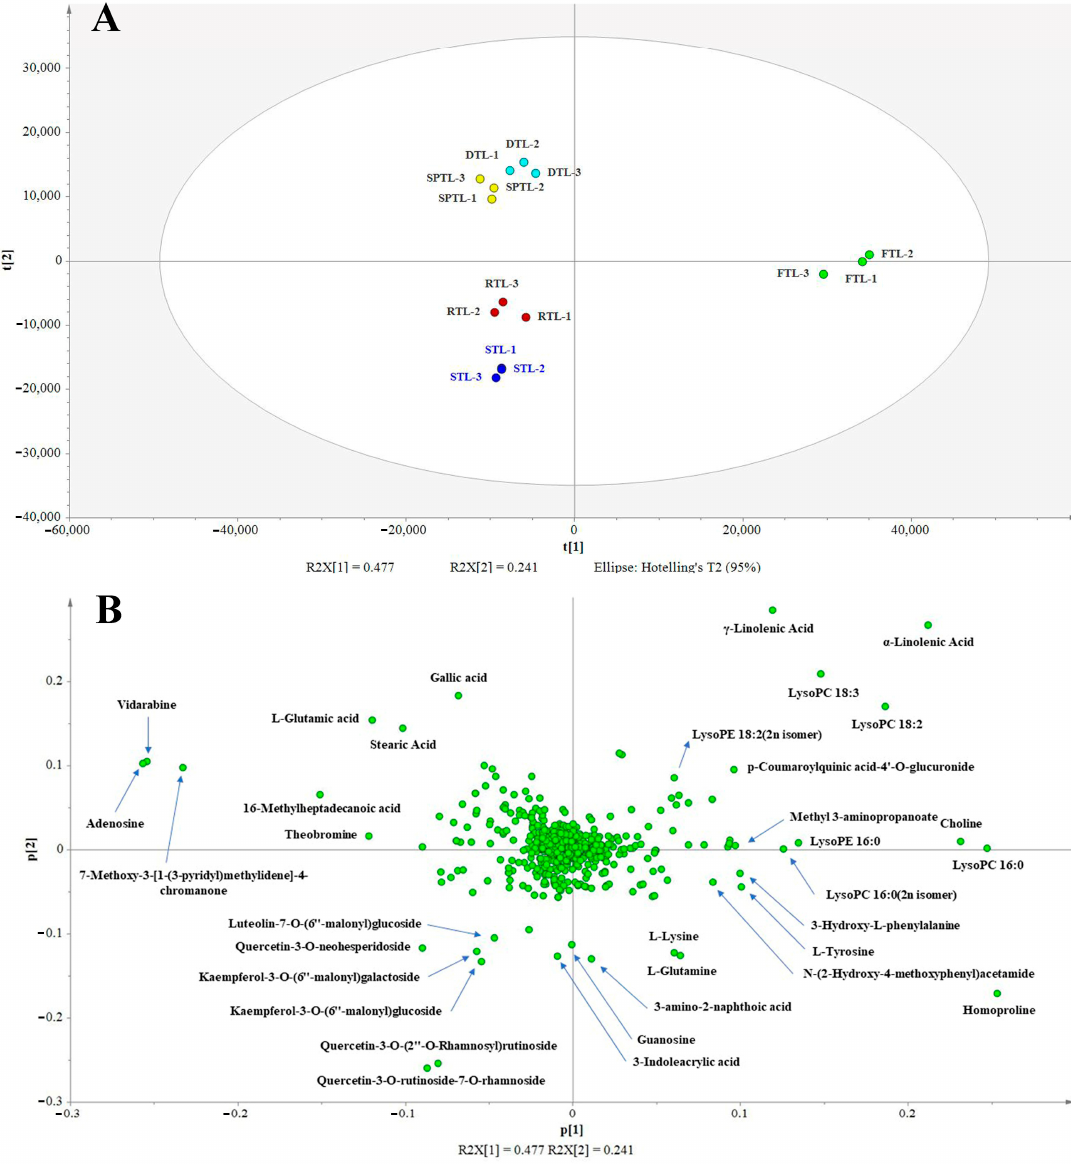
Figure 2. Principal component analysis score ( A ) and loading ( B ) plot of tea samples. R 2 X = 0.718, Q 2 = 0.601. The data were Pareto-scaled.